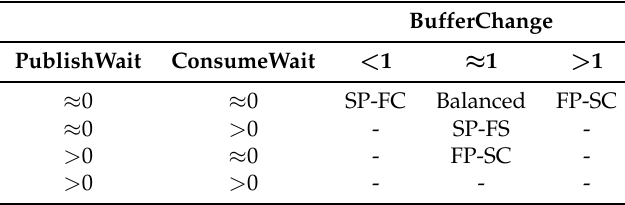
Table 2. Producer/consumer categorization, indicating in which category the producer and consumer belong to with the following possibilities: fast producer slow consumer (FP-SC), slow producer fast consumer (SP-FC), balanced producer and consumer (Balanced), and pathological states